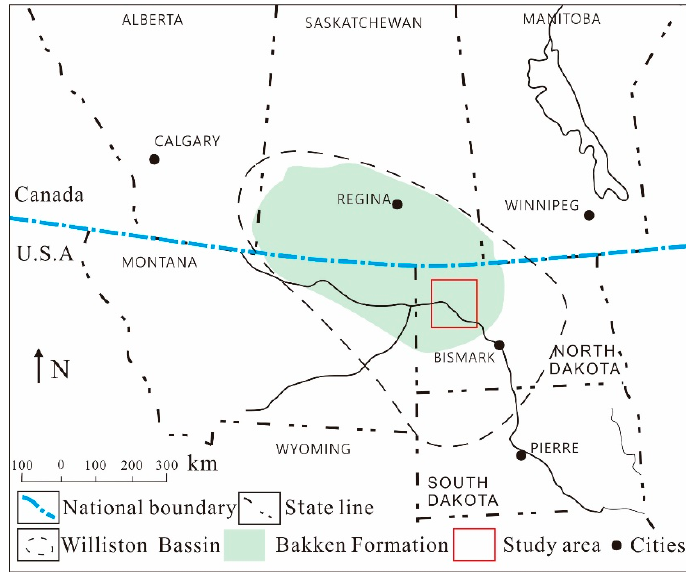
Figure 1. Location of the Williston Basin and study area.